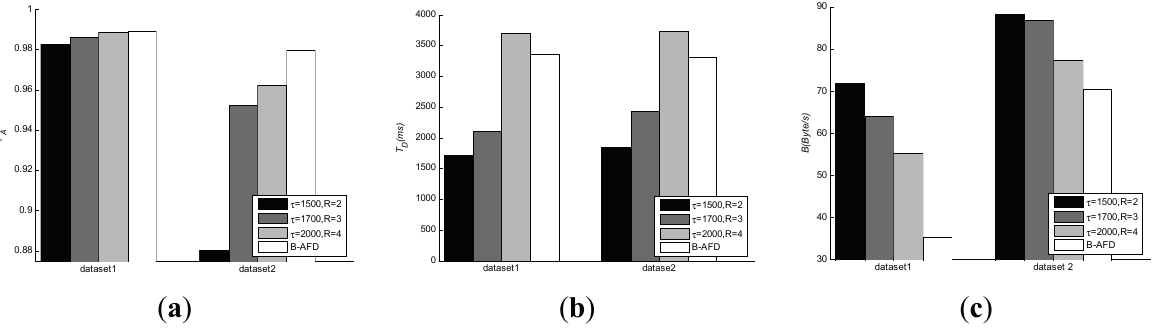
Figure 3. Comparison with baseline strategy. ( a ) detection accuracy; ( b ) detection time; ( c )